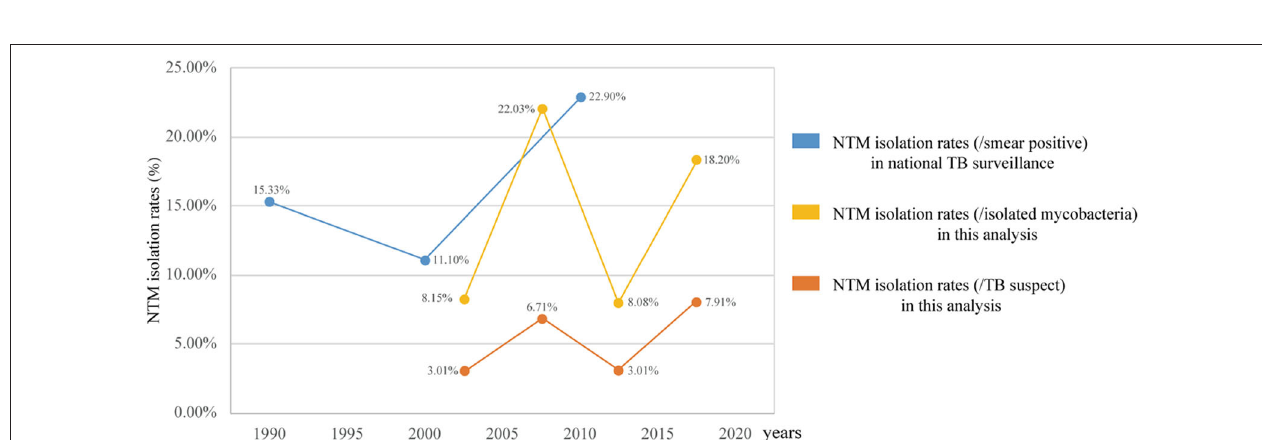
Frontiers in Public Health |